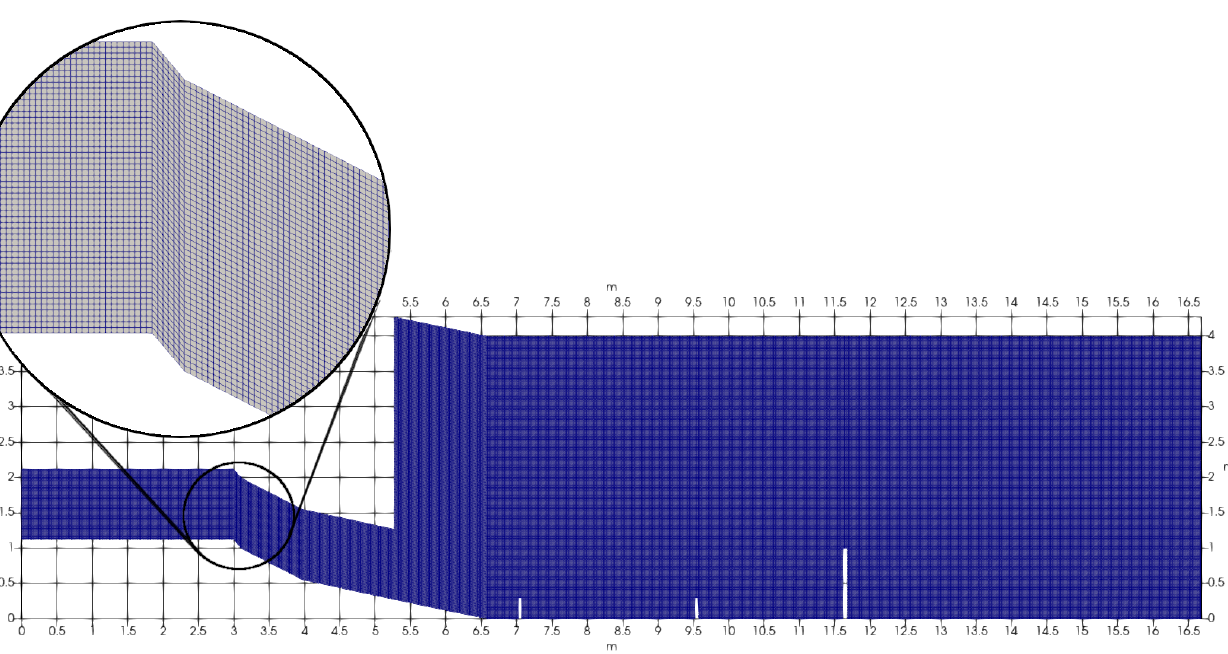
Figure 5. Calculation mesh for University of Iceland experiment